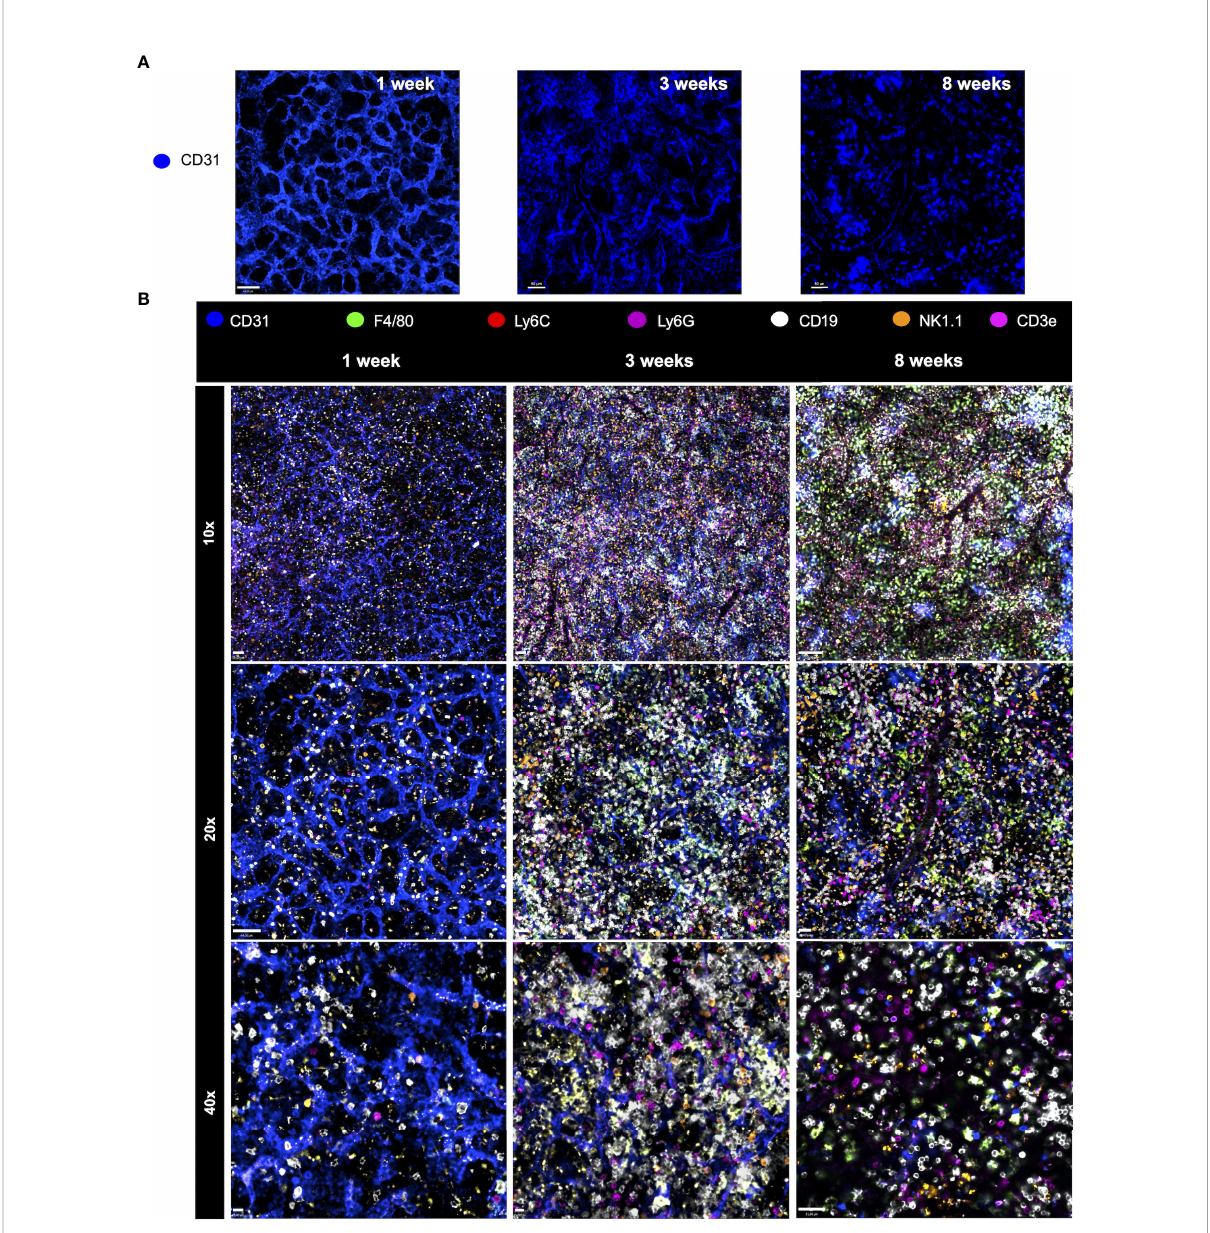
FIGURE 6 Major changes in immune cell population during the postnatal period is accompanied by alterations in the vascular network. (A) Changes in the spleen vascular network during postnatal development. For this, mice were injected with anti-CD31 (anti-PECAM-1; in blue; stains for endothelial cells) and imaged under confocal intravital microscopy. (B) Merged channels images permit the visualization of different immune cell populations at distinct ages. Spleen staining in different ages using WT mice that received i.v. anti-CD31 (in blue), anti F4-80 (in green), anti- Ly6C (in red), anti-Ly6G (in purple), anti-CD19 (in white), anti-NK1.1 (in orange) and anti-CD3e (in